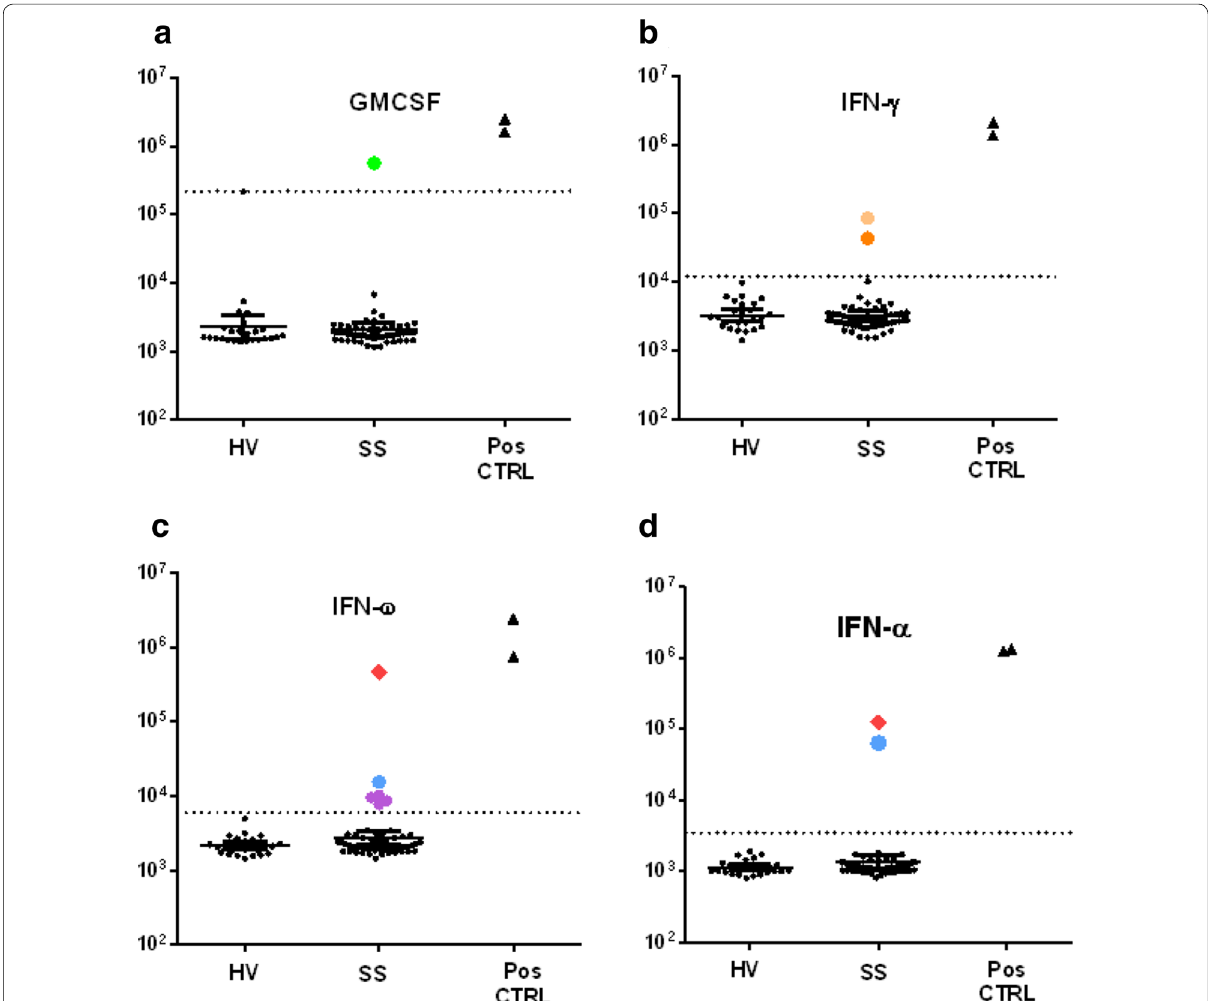
Fig. 1 Detection of cytokine autoantibodies in SS. Using LIPS, autoantibodies against GMCSF ( a ), interferon-γ ( b ), -ω ( c ), and -α ( d ), were evaluated in 25 healthy volunteers (HV) and 57 Sjogren syndrome (SS) patients. Each circle on the graphs represents an individual subject. Autoantibody levels are expressed in LU. For each test, two appropriate positive serum from PAP, DNTB and thymoma patients were used as internal controls. The short solid lines for the HV and SS patients represent the geometric mean levels and 95% confidence interval for the autoantibody level in each group. The dashed lines represent the cut-off values defined as described in “Methods”. The SS patient (#56) with high levels of autoantibodies against interferon-α and interferon-ω is denoted by the red